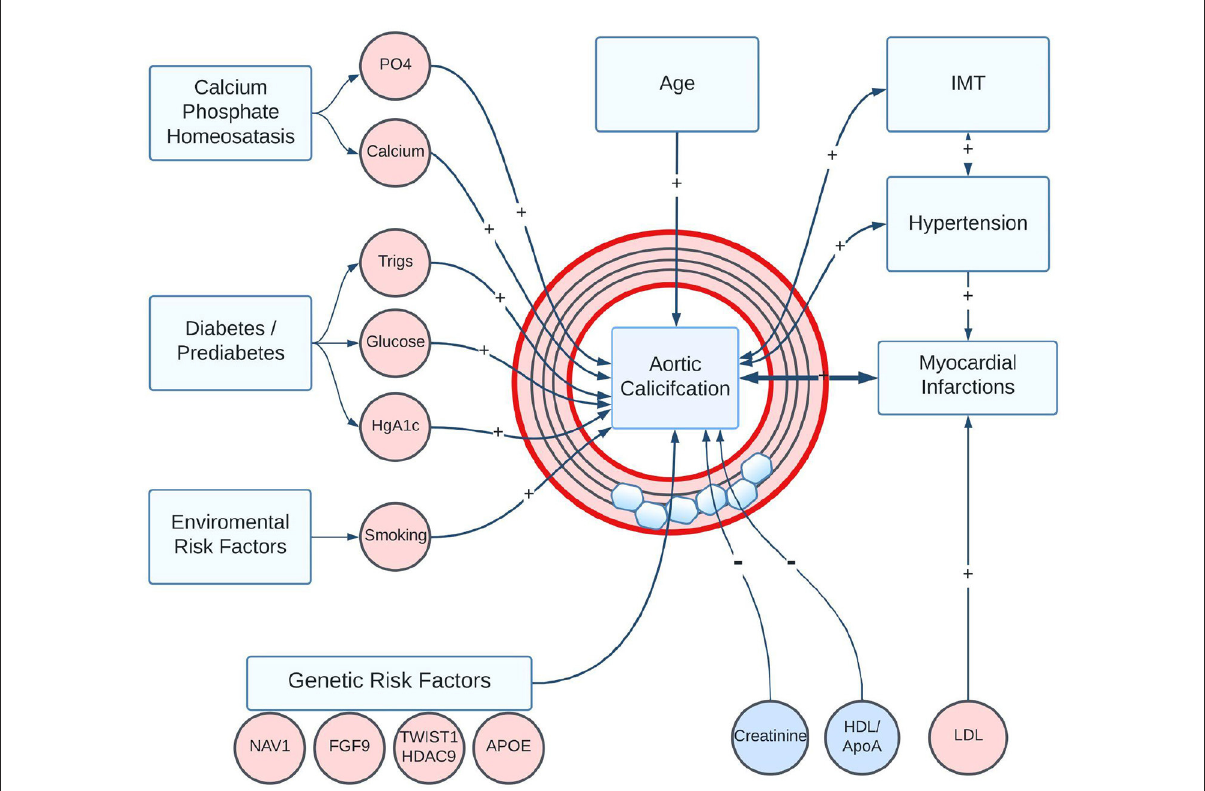
FIGURE11 Summary of statistically significant risk factors associated with the development of AAC in the UK Biobank Imaging Cohort. Positive associations are shown as “ + ” arrows, and negative associations are shown as “-” arrows. Age, smoking, diabetic/pre-diabetic state, and elevated plasma levels of Ca/PO4 are the biggest risk factors for the development of AAC. Notably, reduced kidney function and elevated LDL were not associated with increased AAC. A strong positive association between AAC and poor future CVD outcomes could arise through a combination of direct effects on vascular structure, indirect effects such as loss of vessel compliance and increased hypertension, or through induced correlation with calcification in other vascular